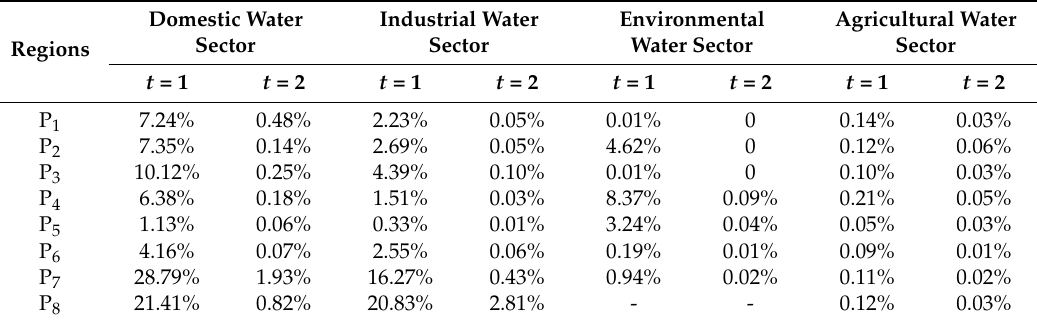
Table 7. The coefficient of variation for water allocation under different scenarios.